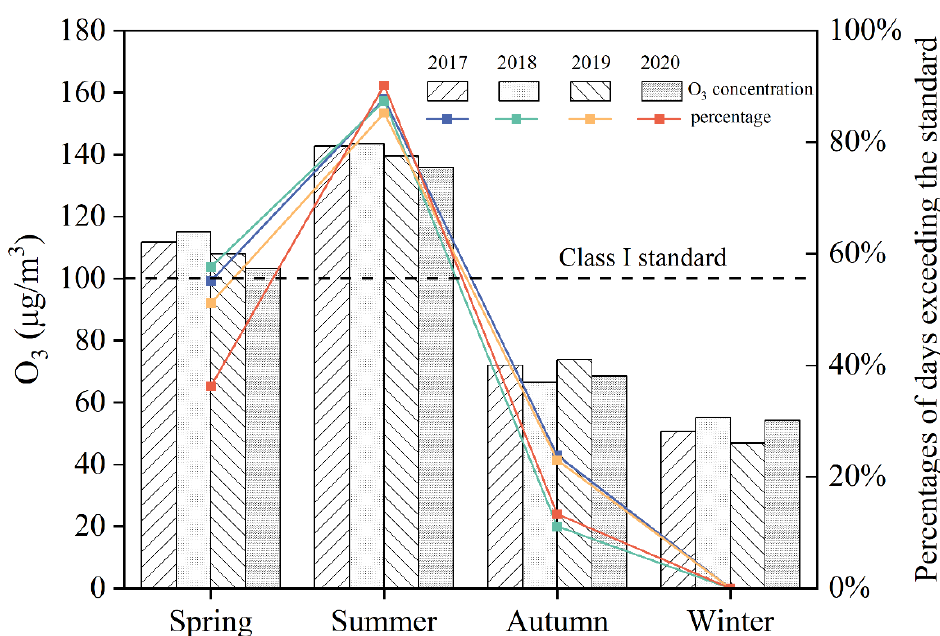
Figure 5. Seasonal average O 3 concentrations and the percentages of O 3 exceedance days.